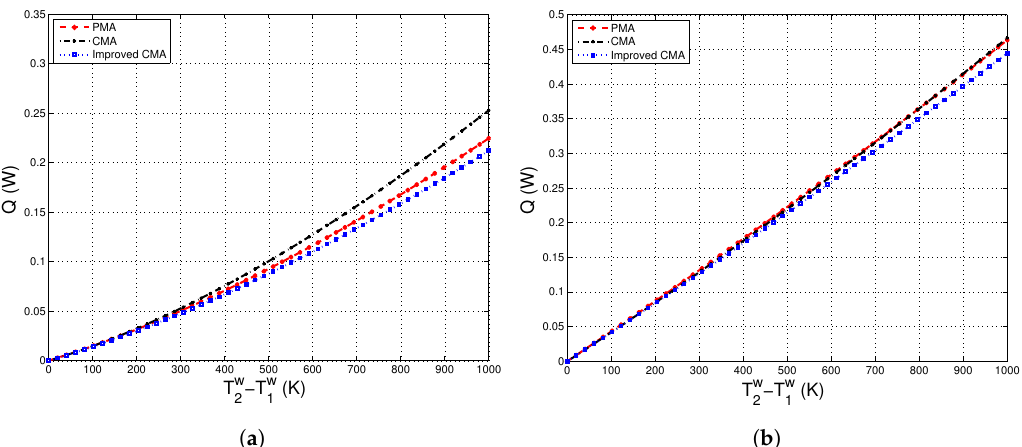
− T w , evaluated at different compaction strains: 2 1